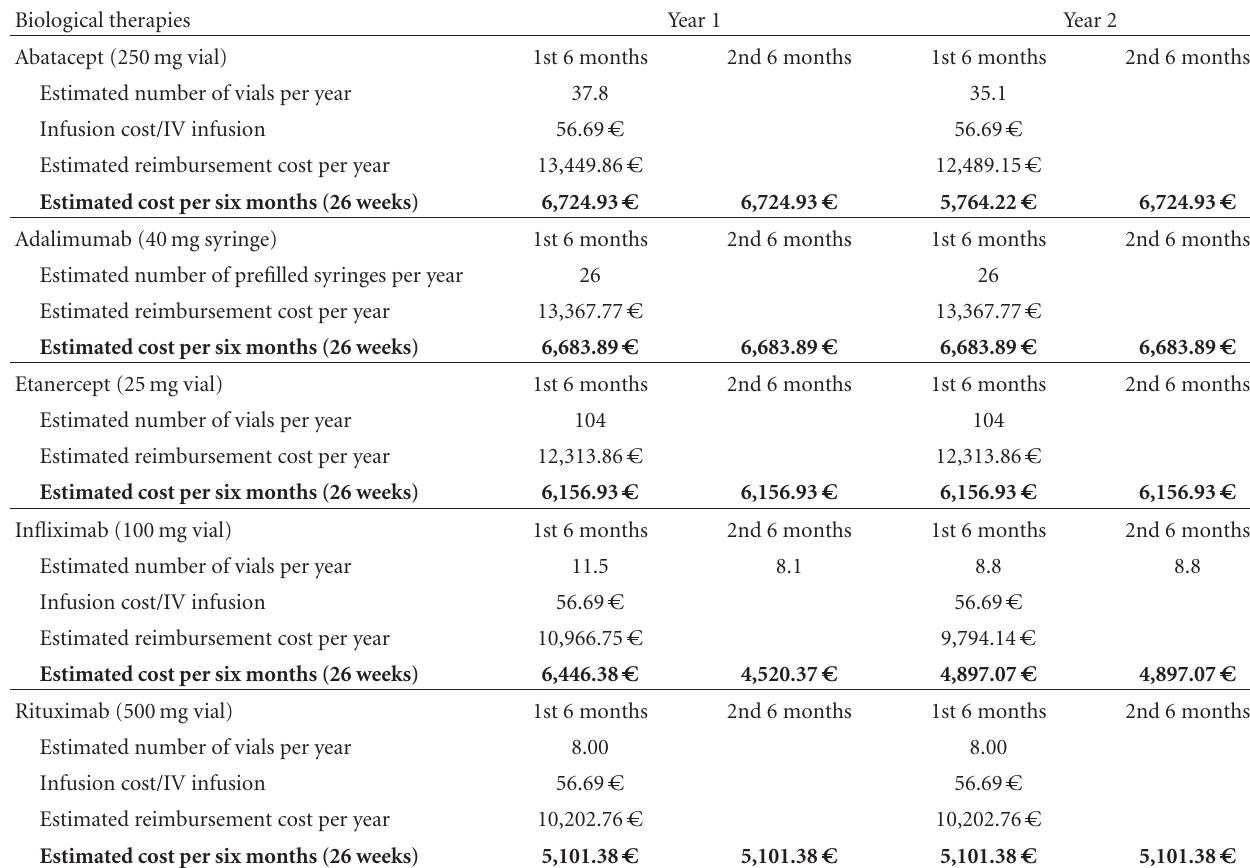
Table 2: Estimated biological treatment costs.